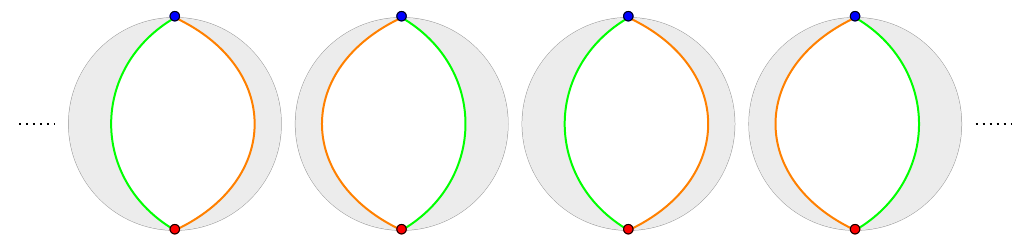
Figure 7. An array of AdS 3 wedges such that the adjacent branes for contiguous wedges are of equal tension. In other words, the orange branes and green branes are respectively of equal tension.